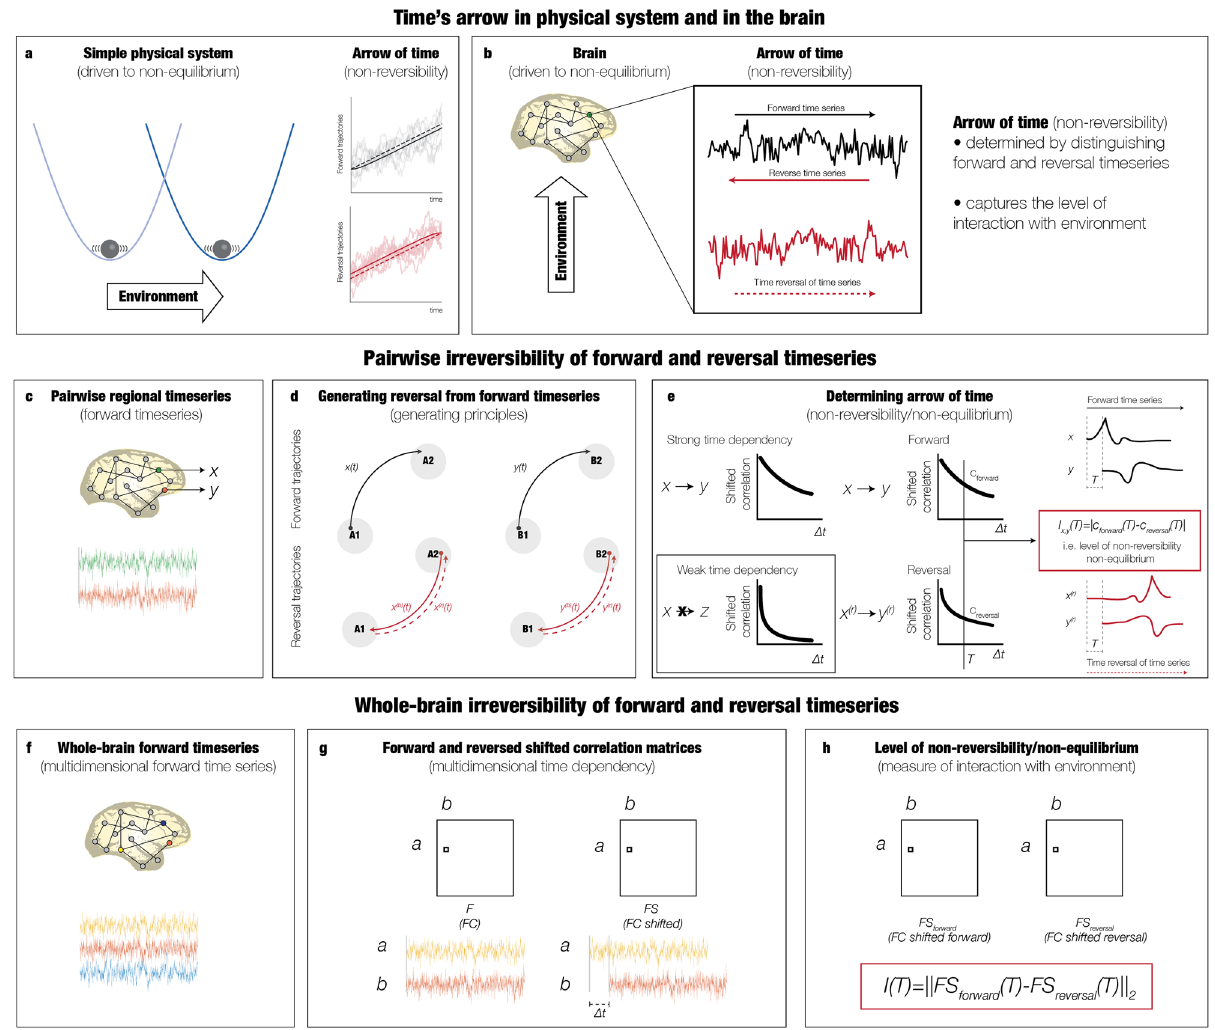
Fig. 1 Capturing signatures of brain states estimating the inside out balance of intrinsic and extrinsic dynamics. The arrow of time in brain signals contains a precise signature of the reversibility, re fl ecting how the brain is driven by the level of interaction with the environment. a In thermodynamics, the arrow of time in physical systems can be precisely estimated to provide a measure of non-reversibility and non-equilibrium, i.e. how the system is driven by external forces. The subpanel shows an example of a non-equilibrium system given by a Brownian particle in a moving potential, whose position is controlled externally, moving from one position to another in the forward process. The top of the subpanel shows examples the forward evolving trajectories (light grey lines) with the average (solid grey line). The average trajectory lags behind the centre of the potential (grey dashed line). In contrast (bottom of right subpanel) shows sample backward trajectories (light red lines) and their average (solid red line). Here the average trajectory leads the potential ’ s centre (red dashed line). This asymmetry in time of forward and backward trajectories (i.e. the differences between the lines for average and the potential ’ s centre) provides the exact level of non-reversibility/non-equilibrium of the system [adapted from 18 ]. b The present framework uses this key idea from thermodynamics to extract the arrow of time in brain signals in order to capture the level of interaction between the brain and the environment. c The framework estimates the asymmetry by using pairwise comparisons of forward signals across the whole brain. d This is accomplished by constructing the backward brain signal from the forward signal by creating a reversal of the backward time series in each brain region. The panel shows the notation used for describing this process for a pair of regions. e The panel shows the main principle of the framework for measuring the level of non- reversibility/non-equilibrium through the pairwise level of asymmetry using a time-shifted measure of their correlation. The subpanels show how the shifted correlation captures the causal interactions between two time series where the top example shows strong time dependency while the bottom example shows weak time dependency. This is clearly seen by how the shifted correlation (as a function of the time shift, Δ t) decays more rapidly for signals with weak compared to strong time dependency. The middle subpanels show the same method but now used for comparing forward and reversed regionals pairs of brain signals. The right subpanel shows examples of the time series for a given shift Δ t = T and how the level of non-reversibility is computed as the absolute quadratic difference between the time-shifted correlations between forward and the reversal time series averaged over all pairs. f We applied this framework to the multidimensional time series covering the whole brain. g We created two time-shifted correlation matrices for the forward and reversed time series (at a given shift time point Δ t = T). h The level of non-reversibility/non-equilibrium is given exactly by the distance between the two matrices (see Methods).